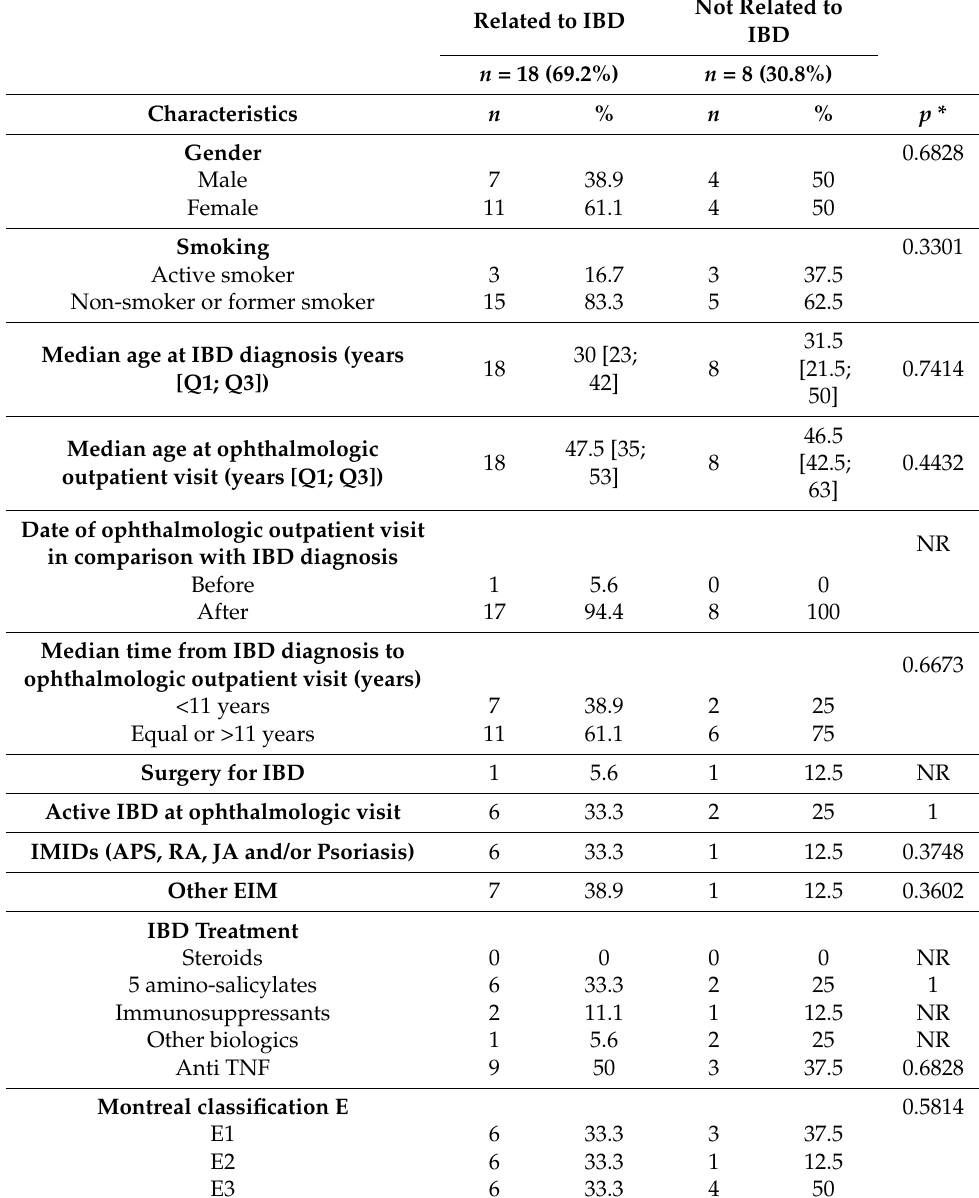
Table 5. Risk factors for ocular manifestations in patients with ulcerative